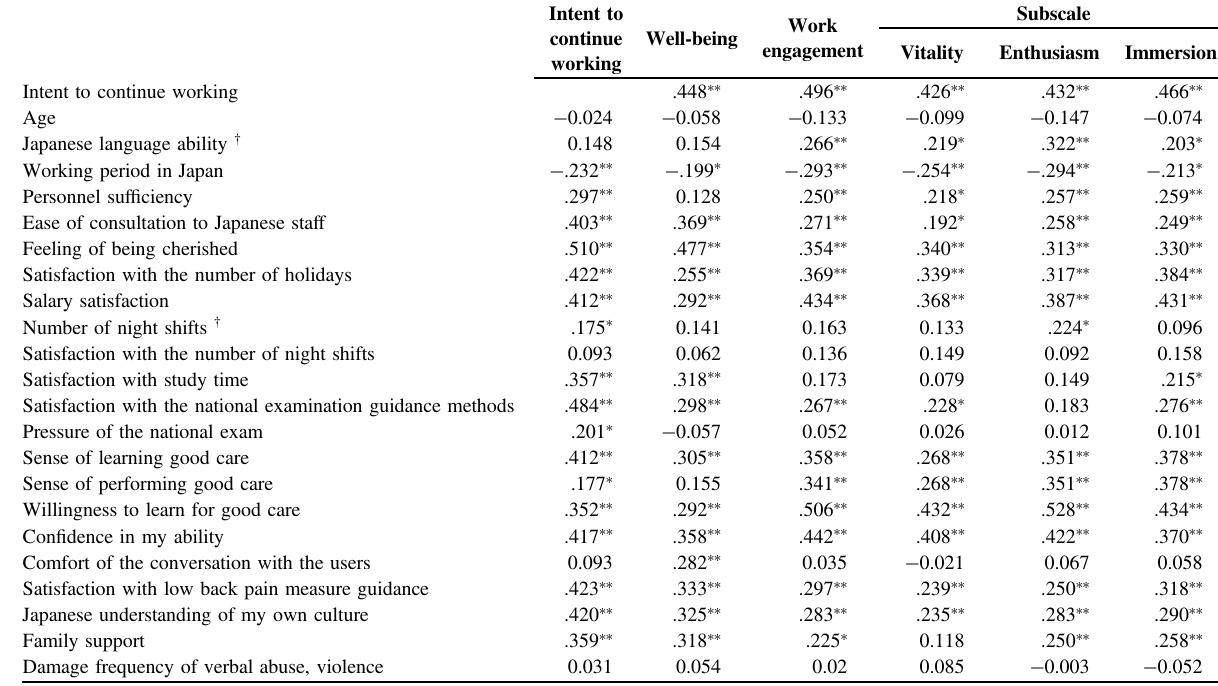
Table 2 Correlation of Participants ’ demographics and original items with intent to continue working, well-being, and work